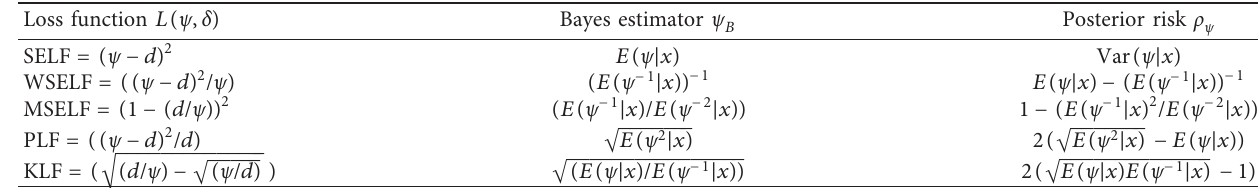
Table 7: Bayes estimator and posterior risk under different loss